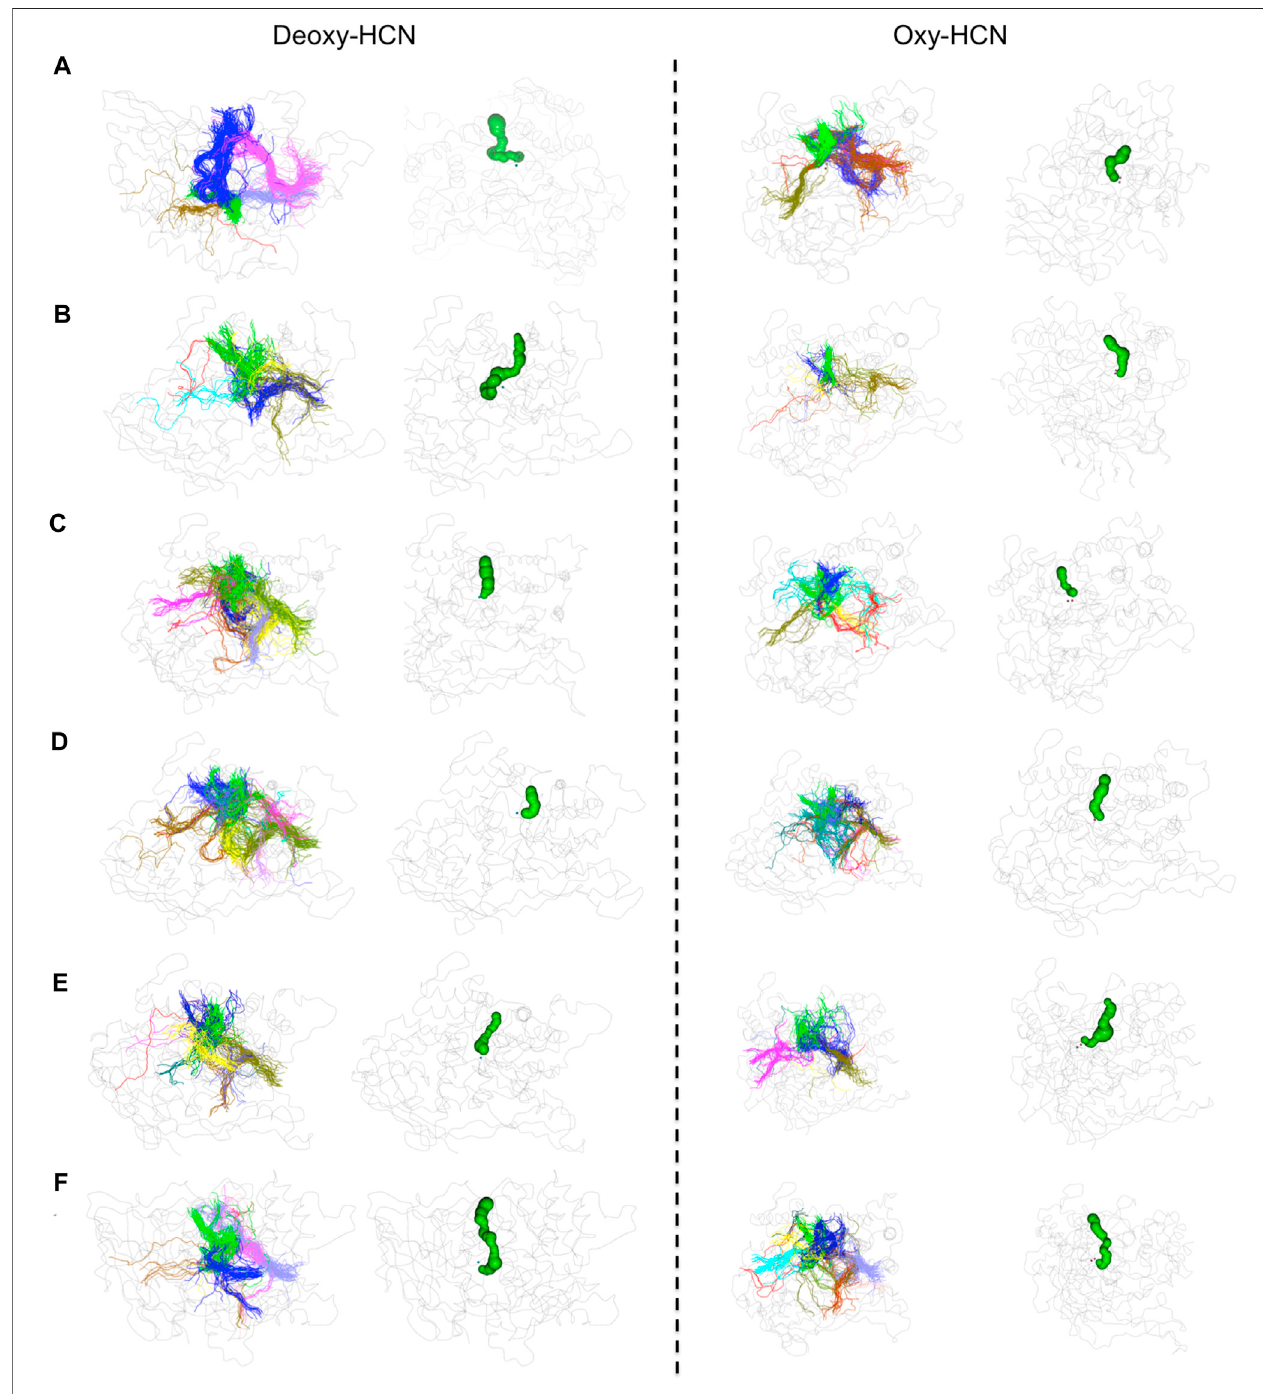
FIGURE 9 | Tunnel analysis in Deoxy-HCN and Oxy-HCN. Tunnel clusters identi fi ed in each monomer are illustrated with distinct colors. The tunnel formed by the top cluster is highlighted in green.